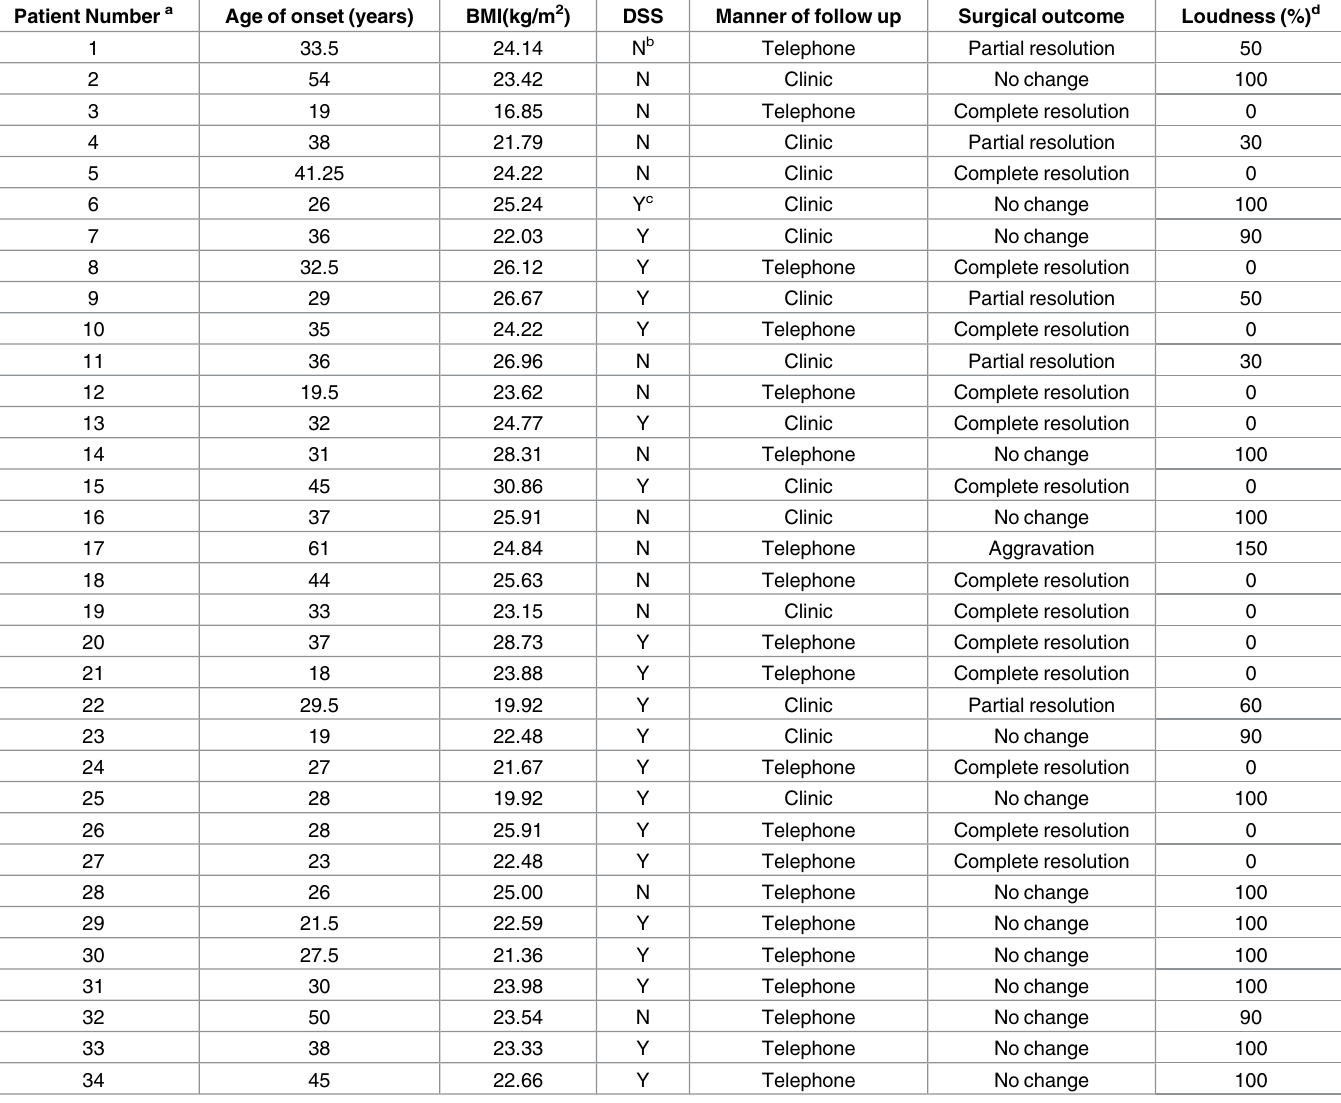
Table 1. Patient